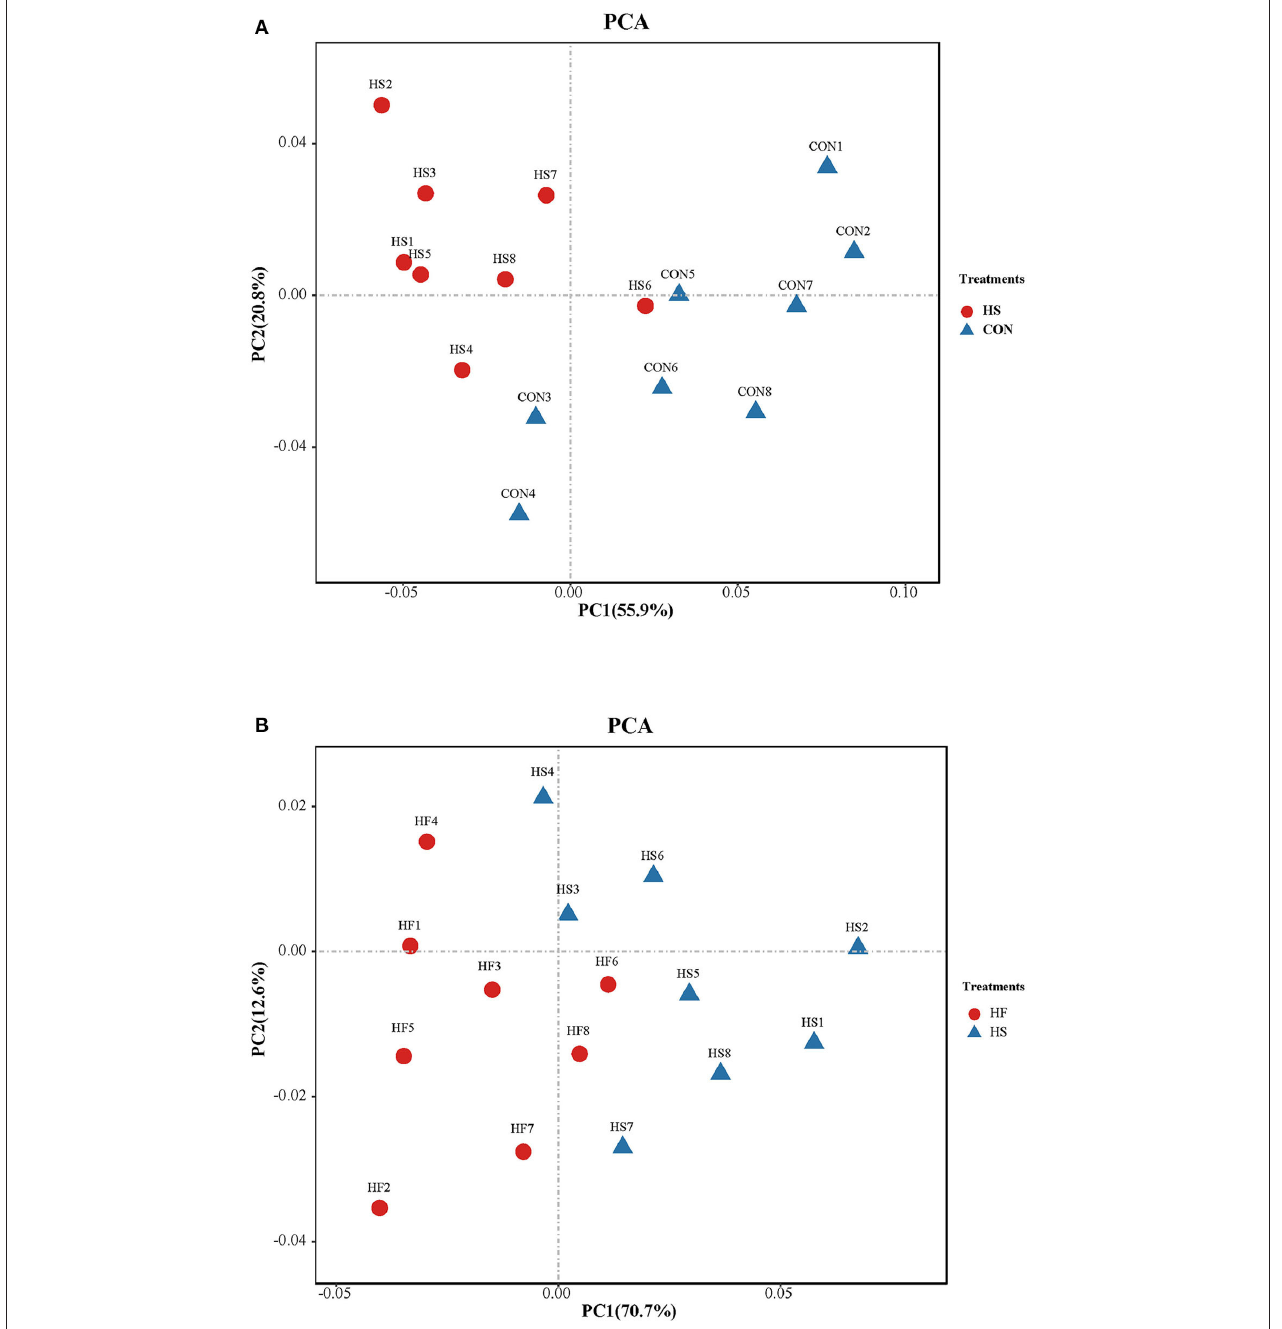
FIGURE 3 | Principal components analysis (PCA) on ruminal metabolite content between different treatments. (A) Principal components analysis (PCA) on ruminal metabolites content between CON and HS treatments. CO, control treatment; HS, heat stress treatment. (B) Principal components analysis (PCA) on ruminal metabolite structures between HS and HF treatments. HS, heat stress treatment; HF, honeycomb flavonoids supplement treatment.